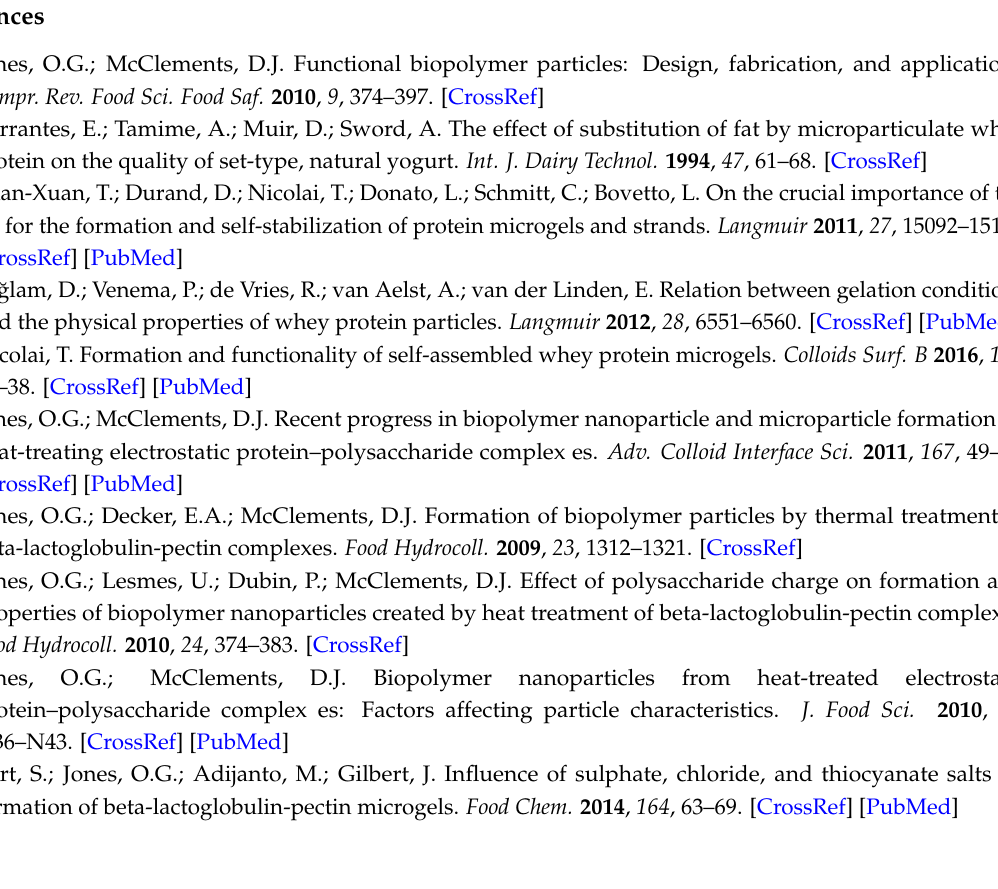
scattered light at 90 degree scattering angle for mixtures of α -lactalbumin and (a) CH 76 PEG or (b) CH 76 at different r -values as a function of solution pH; Figure S3. Effect of r -value on turbidity of α -lac complexes heated at